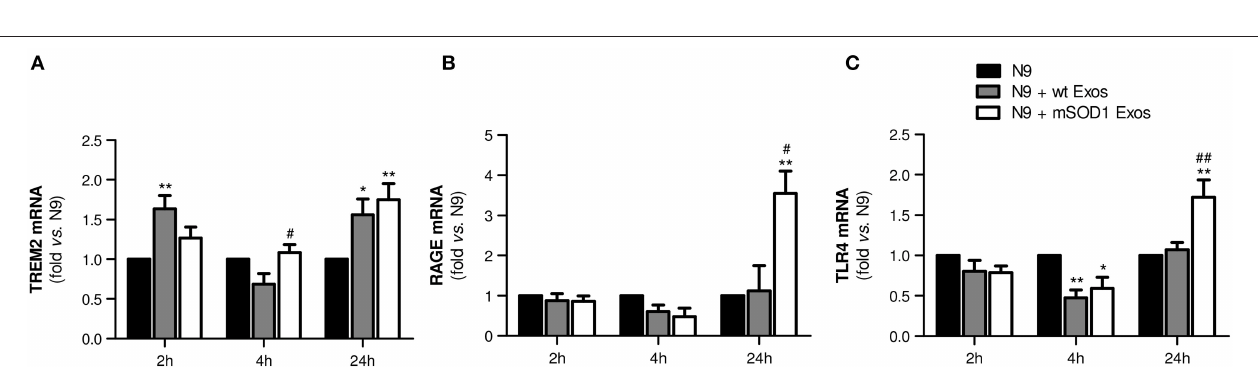
( Figure 3D , p < 0.05), emphasizing secretome relevance in the signaling mechanisms underlying HMGB1-induced microglial